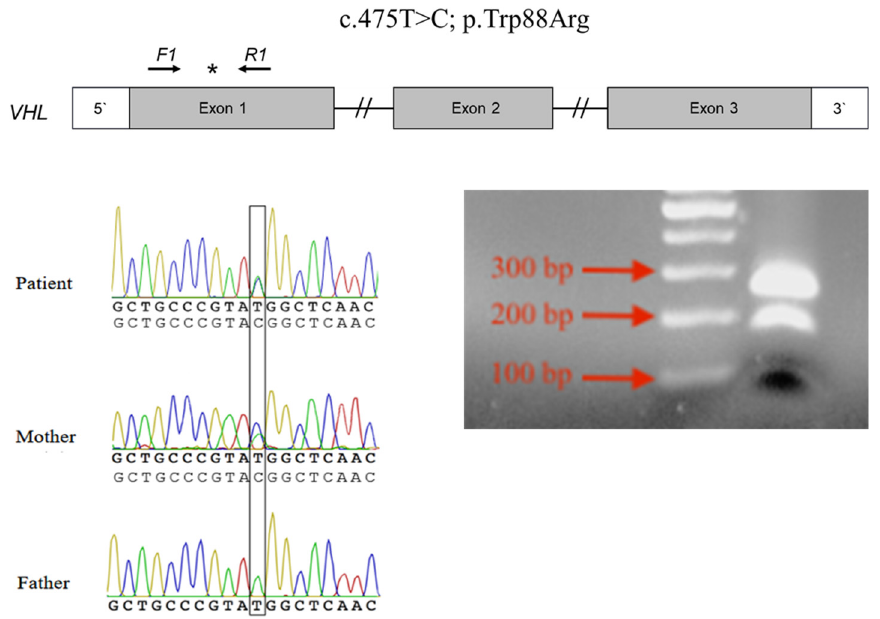
Figure 2. Detection of VHL gene mutation (c.262T > C) in the patient and his family. (* refers to the mutant site in the amplicon).